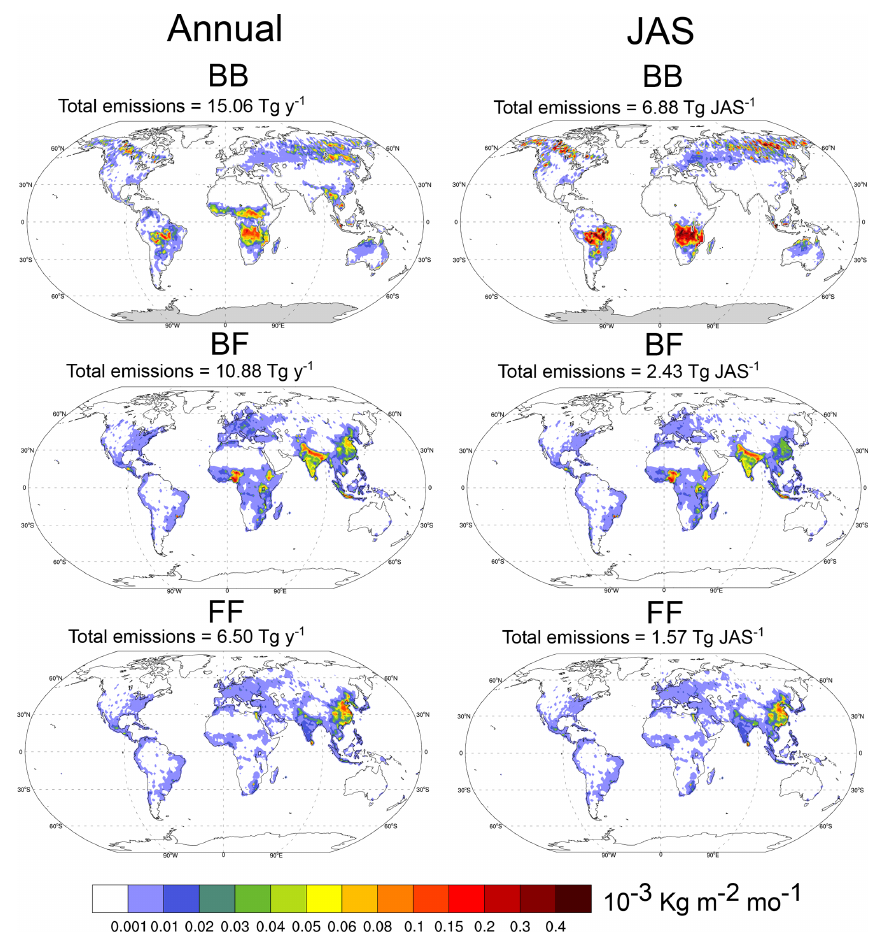
Figure 2. Annual and JAS biomass burning (BB), biofuel (BF), and fossil fuel (FF) organic carbon emissions (10 − 3 kgm − 2 mo − 1 , 2000– 2014 average). BB and BF emissions correspond to BrC emissions in the BRC_NOBL and BRC model runs. Total BB emissions (Tg) in the period are given on top of each